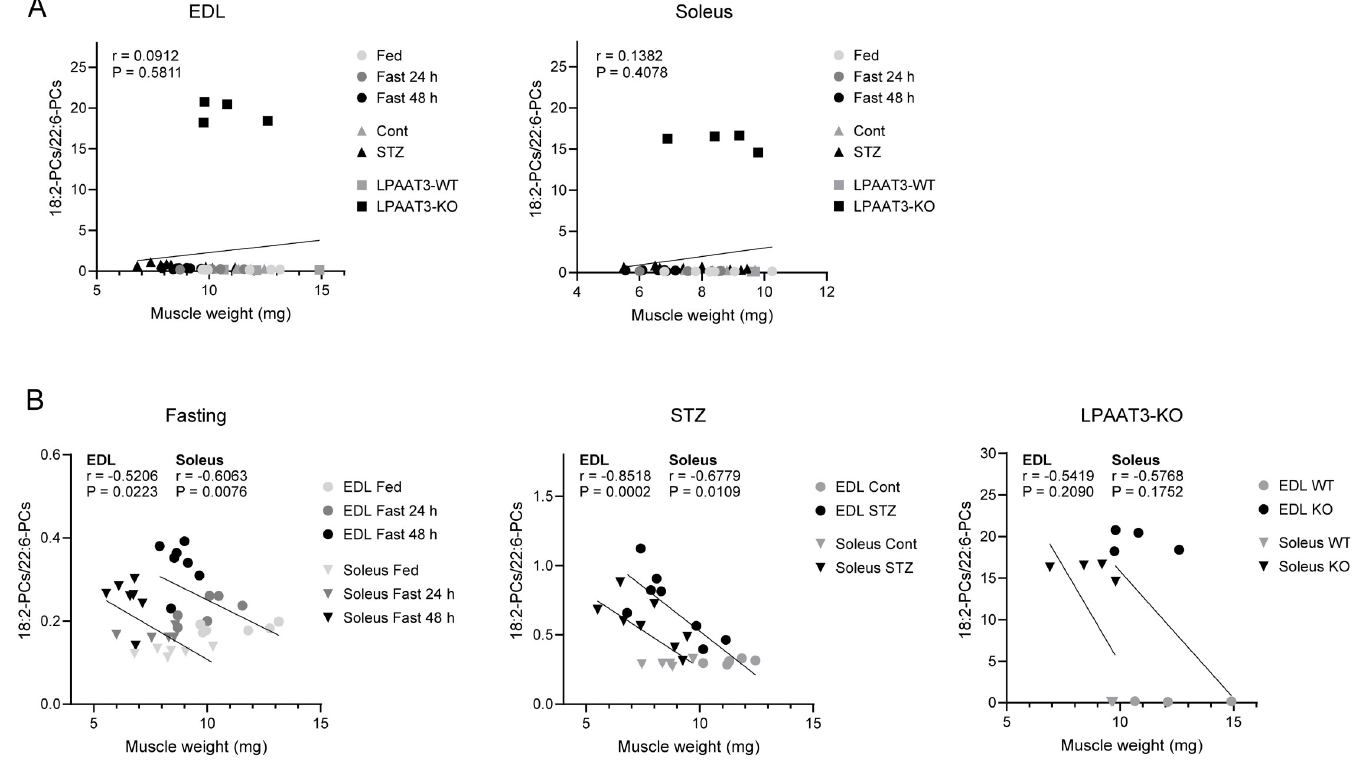
Fig 6. Correlation analyses between PC alteration and muscle mass. Two-tailed Pearson’s correlation tests for EDL and soleus were performed with the ratio of 18:2-PCs/22:6-PCs and muscle weight in all models. These included fasting, ad lib feeding (Fed), and fasting (Fast) mice (n = 6–7); STZ injection, control (Cont) and STZ-injected (STZ) mice (n = 5–8); WT and LPAAT3-KO mice (n = 3–4) (A) and individual models (B). (Fig 2). Importantly, in both fasting and insulin-depleted statuses, decreases in 22:6-PCs were adequately compensated for by increases in 18:2-PCs (Figs 1 and 2). It seems that a compensa- tory mechanism functions in skeletal muscle to maintain a certain amount of PUFA-contain- ing PCs. This notion is supported by the PC profiles of LPAAT3-KO muscles, in which loss of 22:6-PCs led to a considerable accumulation of other PCs, especially 18:2-PCs, although total PUFA-containing PC levels were still lower in LPAAT3-KO muscles (Fig 5). and LPCAT3, was enhanced by fasting; however, no consistent alteration was found upon STZ-injection. In addition, no acyltransferase could adequately explain 22:6-PCs decreases in